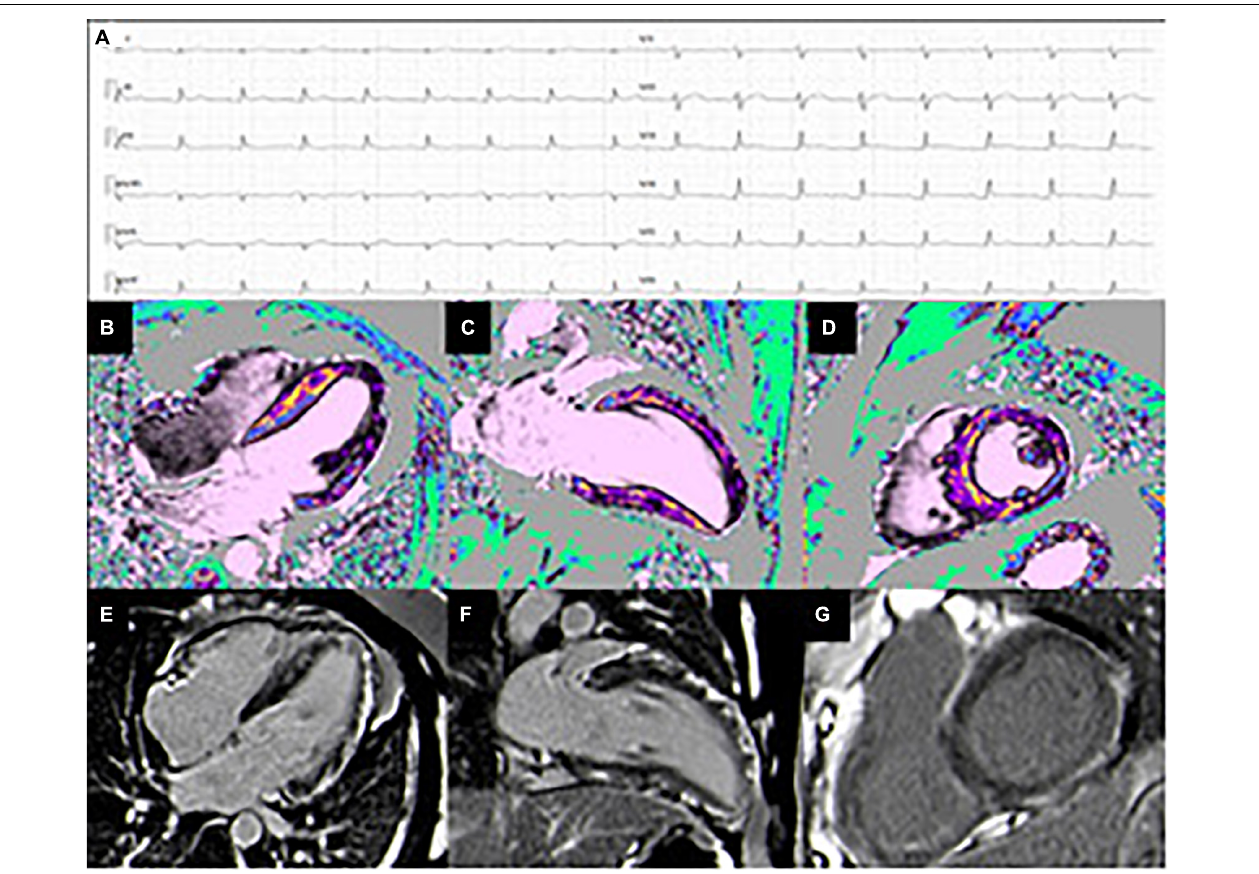
FIGURE 3 | Case of a 50 y/o male with low-risk profile hospitalized for chest pain. (A) ECG pattern during chest pain showing PR-depression with diffuse ST-elevation. The coronary angiography was negative for significant lesions. (B–D) T1 mapping shows diffuse increased value more evident in the anterior and lateral wall, compatible with myocardial edema (4-chamber, 2-chamber, and short-axis views). (E–G) Extensive subepicardial LGE in the infero-lateral and in the antero-septal wall (4-chamber, 2-chamber, and short-axis views).